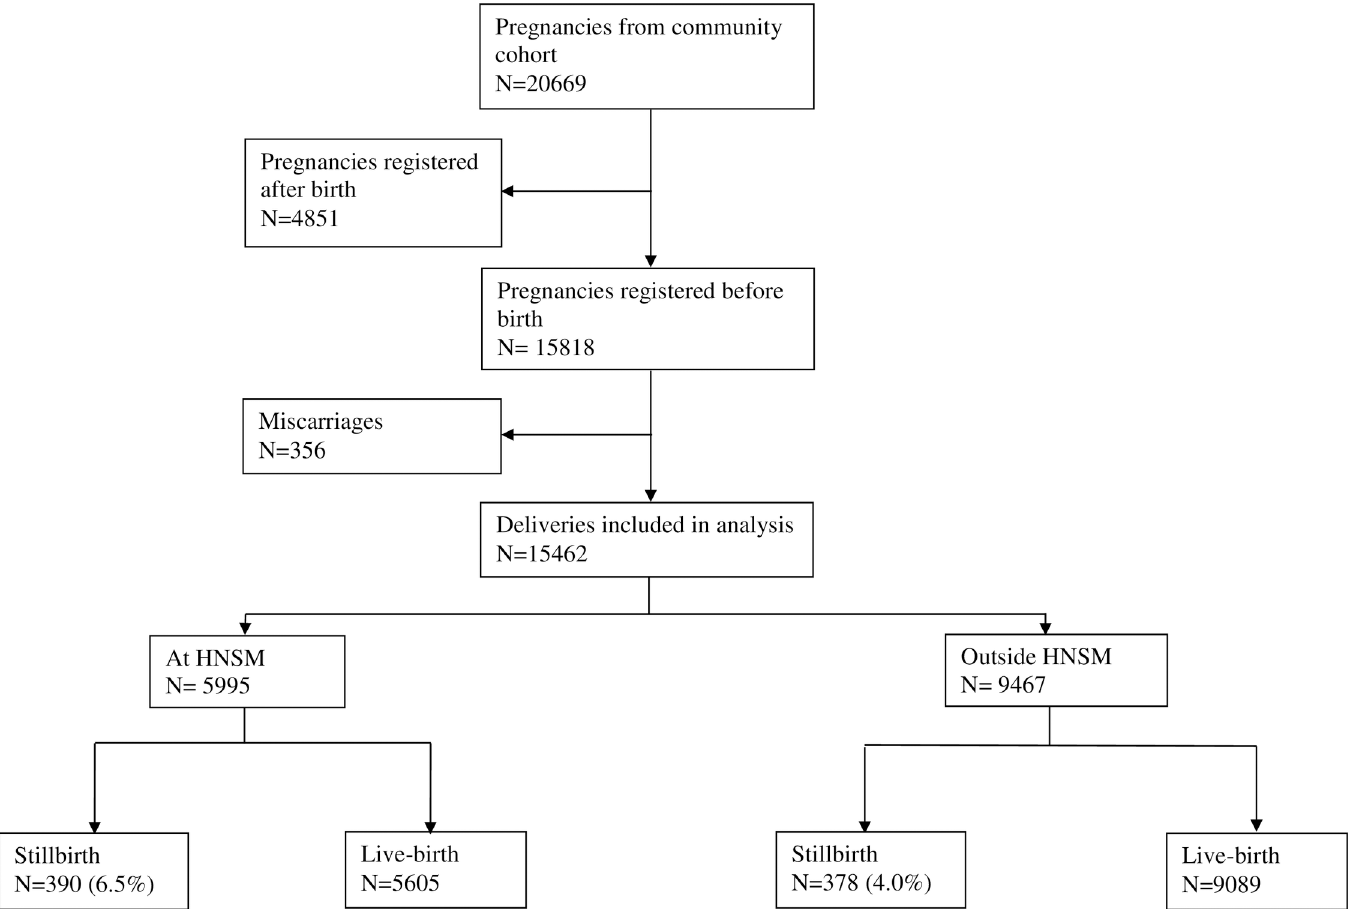
Fig 2. Community cohort (BHP area) deliveries. The figure illustrates births and stillbirths in the community cohort, including how many occurred at the HNSM and outside the hospital.